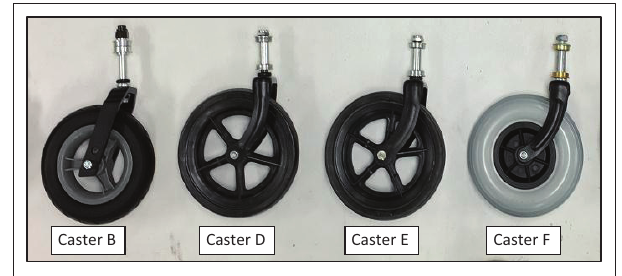
FIGURE 15: Caster assemblies tested in preliminary testing study (Model A is not